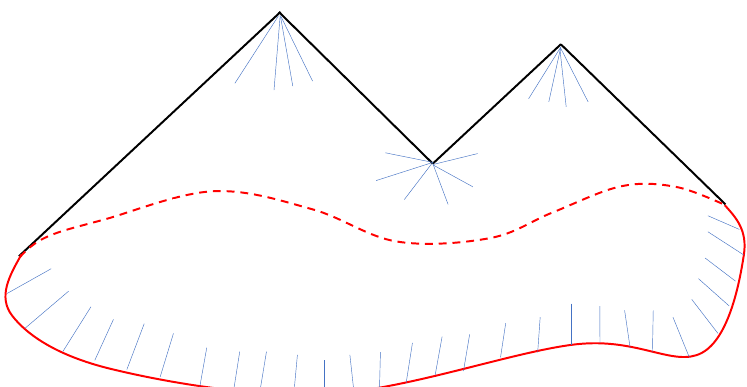
Figure 2 . Schematic image of an abstract manifold with disc topology, with the boundary shown by the wiggled red line. It is flat everywhere except conical singularities. In this example we have two of such singularities with positive angle deficit (positive curvature defects) and the 3rd, in the middle, with negative angle deficit (negative curvature